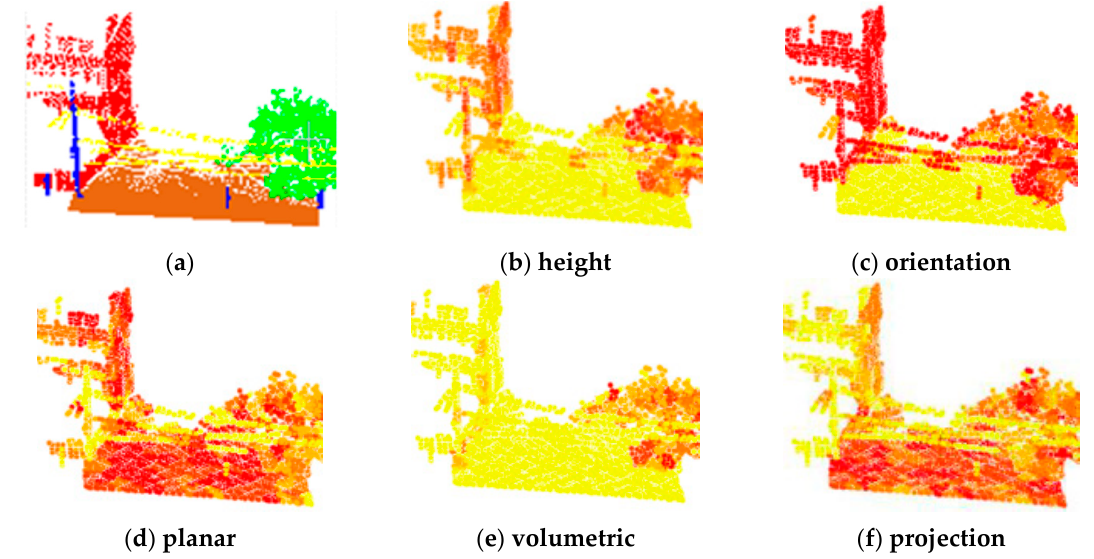
Figure 3. Different feature distribution. ( a ) Point cloud with label, ( b – f ) the value distribution of each feature in the area with color-coded feature values, where yellow represents a low and red a high value.